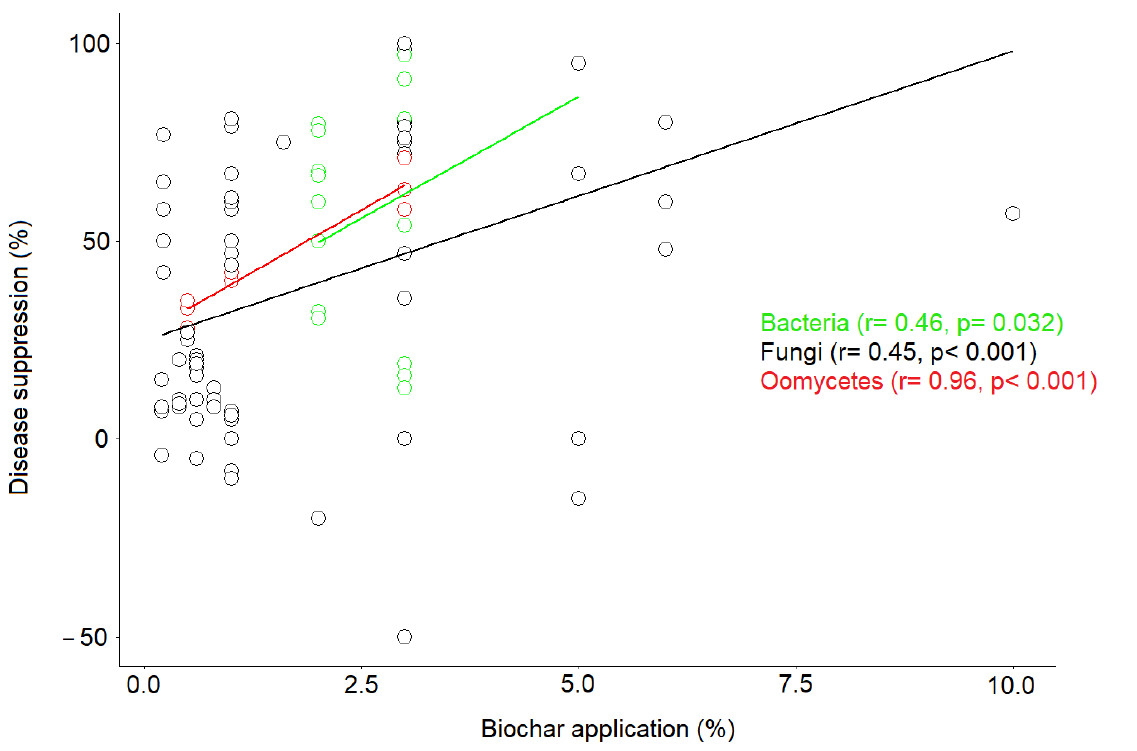
Figure 4. Relationship between disease-suppression rate and biochar application rate recorded for the three most common pathogen types i.e., fungi, bacteria, and oomycetes. The solid-colored lines show a fit by linear regression for each pathogen type.